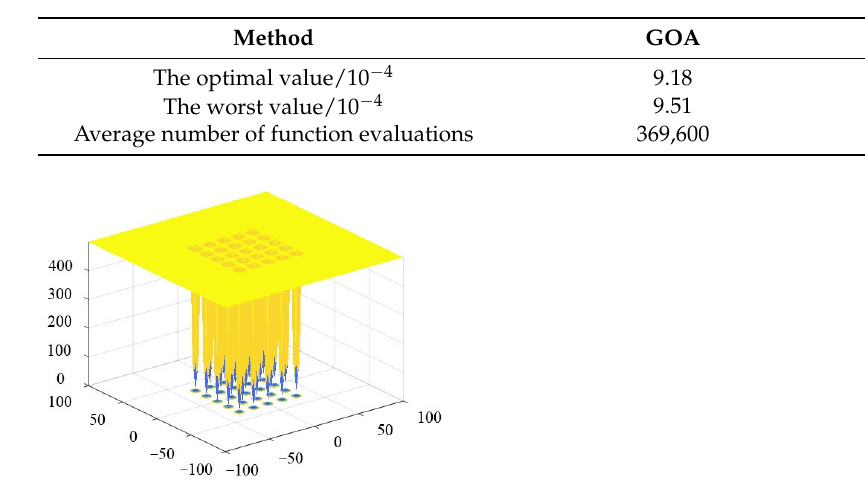
Table 2. Comparison of calculation results for Case 2.